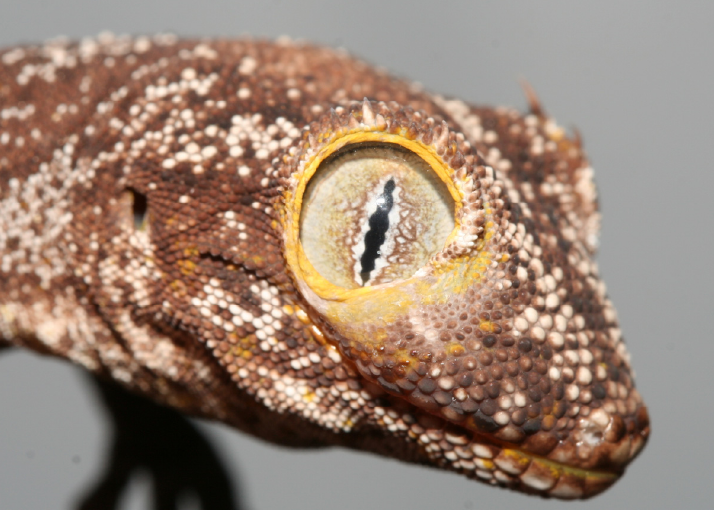
Figure 26. Medial peri-ocular and facial swelling associated with ascending bacterial infection of the